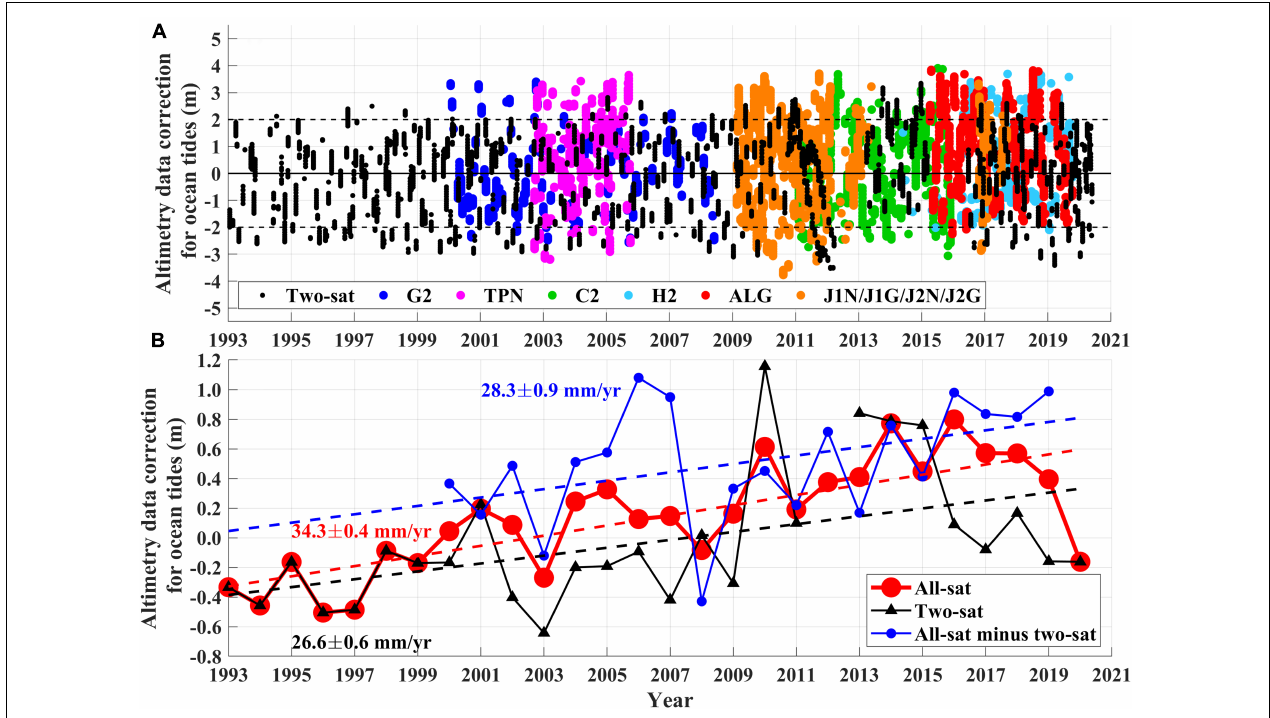
FIGURE 8 | (A) Time series of ocean tide prediction component ( h FES 2014 tide ) used to correct satellite altimetry data by FES2014 model along the tracks for two-sat reference and complementary satellites (black dots) and for other missions for all-sat products (G2; blue, TPN; pink, C2; green, H2; sky-blue, ALG; red, J1N/J1G/J2N/J2G; orange circles). All information is shown for 1 × 1 ◦ grid near TG station IC within Gyeonggi Bay (gray box in Figure 1 and black triangles in Figure 6 ). Horizontal grid lines are denoted at 0 and ± 2 m. (B) As for (A) but showing annual mean values for all-sat (large red circles) and two-sat (black triangles) products, alongside their difference (small blue circles Numbers in colors corresponding to dashed lines denote LTSLR.